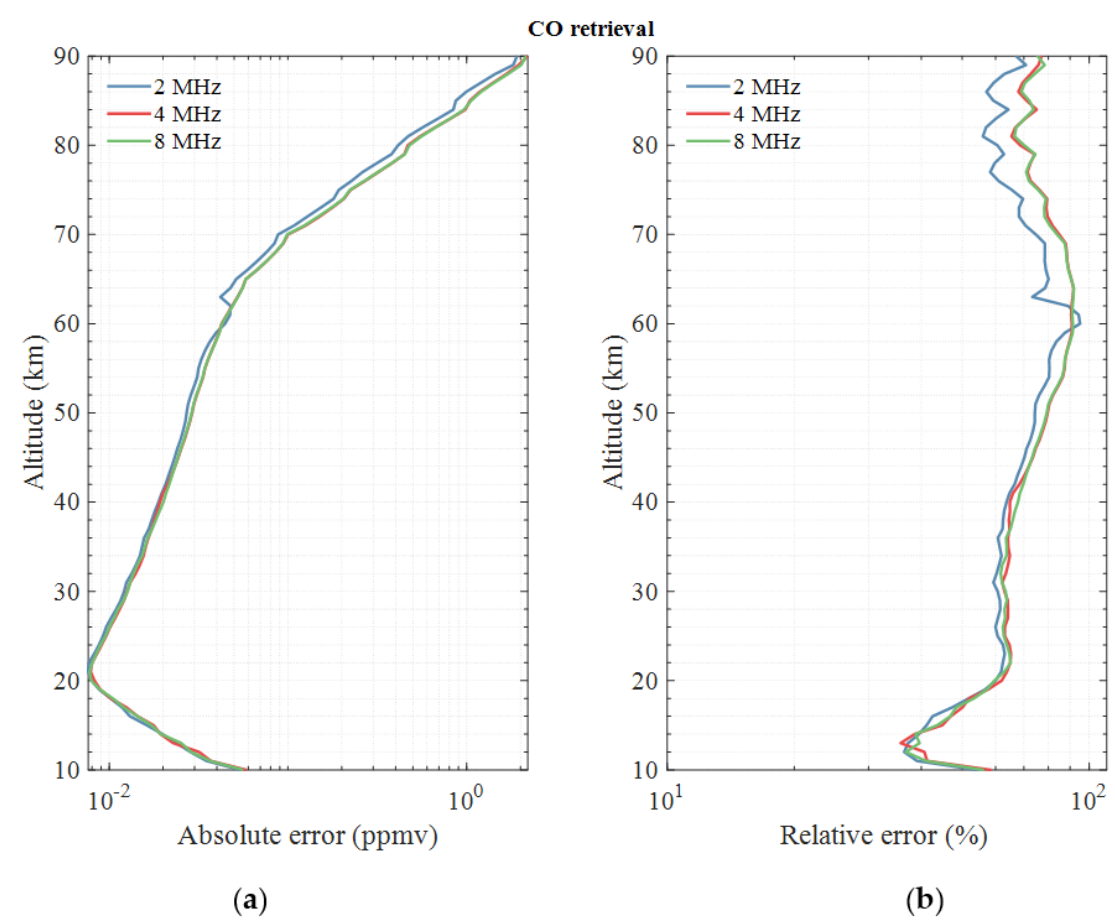
11 Figure 4. Simulated retrieval results of TALIS for CO with different spectral resolutions: ( a ) the absolute error of CO mixing ratio retrieval at spectral resolutions of 2 MHz, 4 MHz, and 8 MHz; ( b ) the relative error of CO mixing ratio retrieval at spectral resolutions of 2 MHz, 4 MHz, and 8 MHz. In the middle and upper atmosphere, the errors caused by the 2 MHz spectral resolution are smaller than those caused by the 4 MHz and 8 MHz spectral